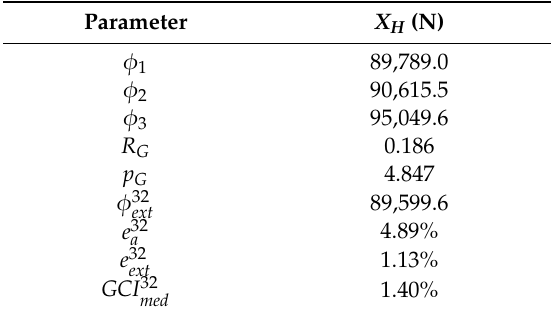
Table 3. Grid convergence study for X H on KNU-020 at y (cid:48) = 0.5 B